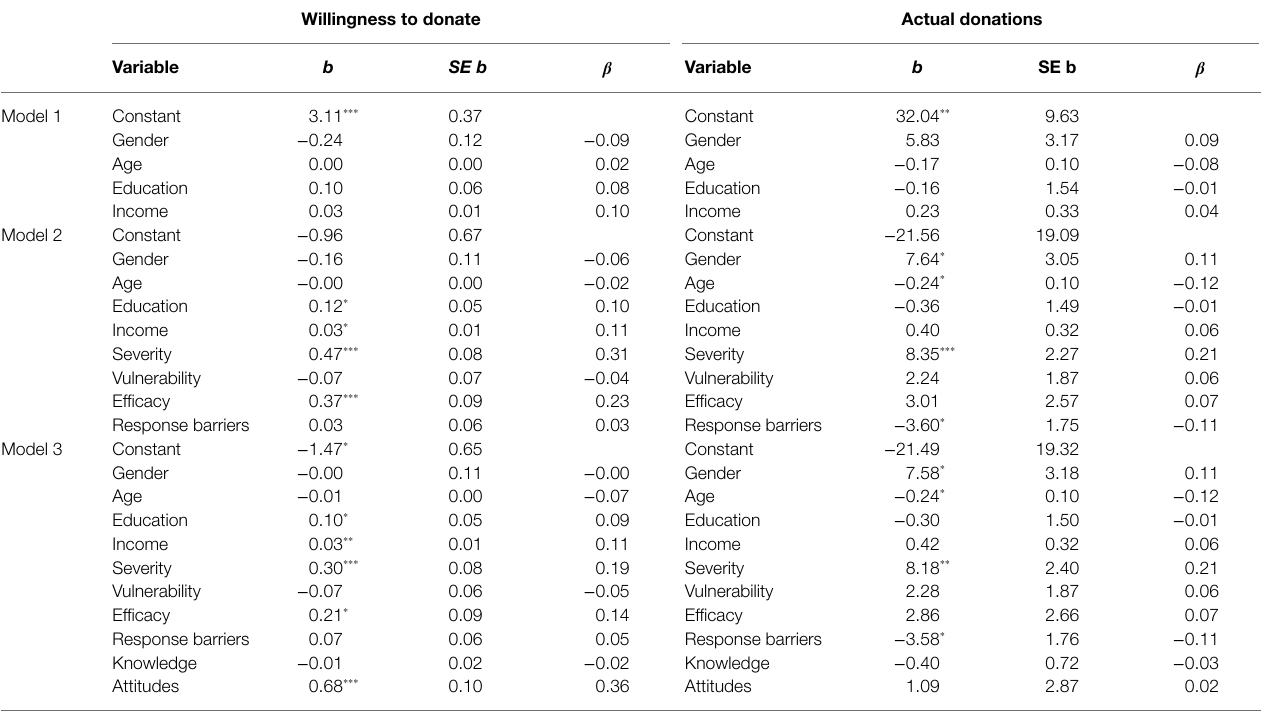
TABLE 3 | Results of multiple hierarchical regression on the influence of the predictors on willingness to donate and actual donations to insect conservation ( N = 469). Willingness to donate Actual